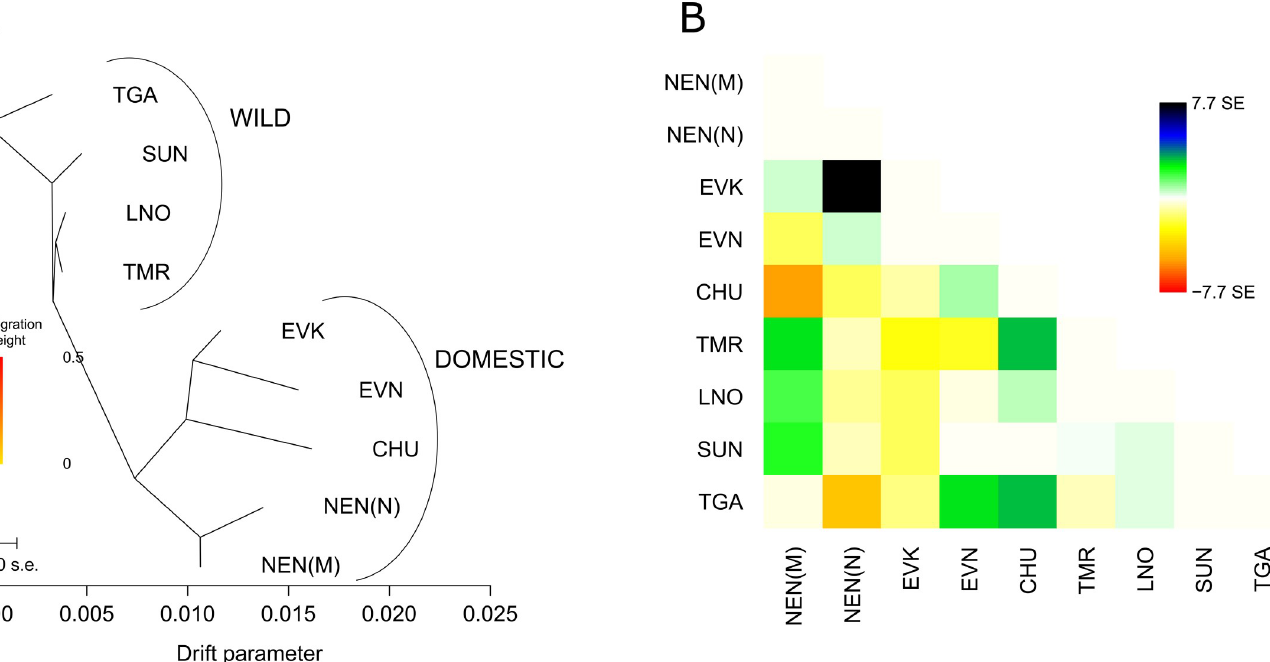
PLOS ONE | https://doi.org/10.1371/journal.pone.0207944 November30,